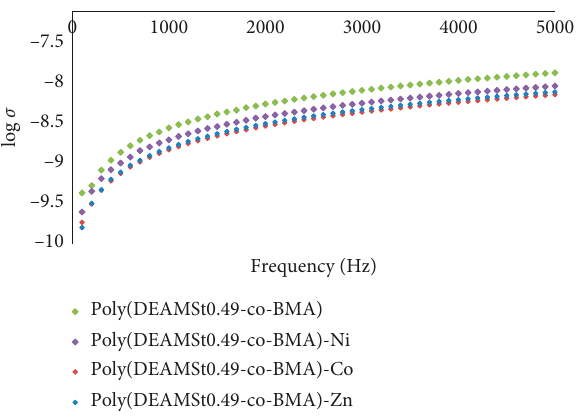
Figure 13: The conductivity change of the poly(DEAMSt0.49-co- BMA) ligand and the poly(DEAMSt0.49-co-BMA)-M metal complexes versus frequency (M: Co(II), Ni(II),